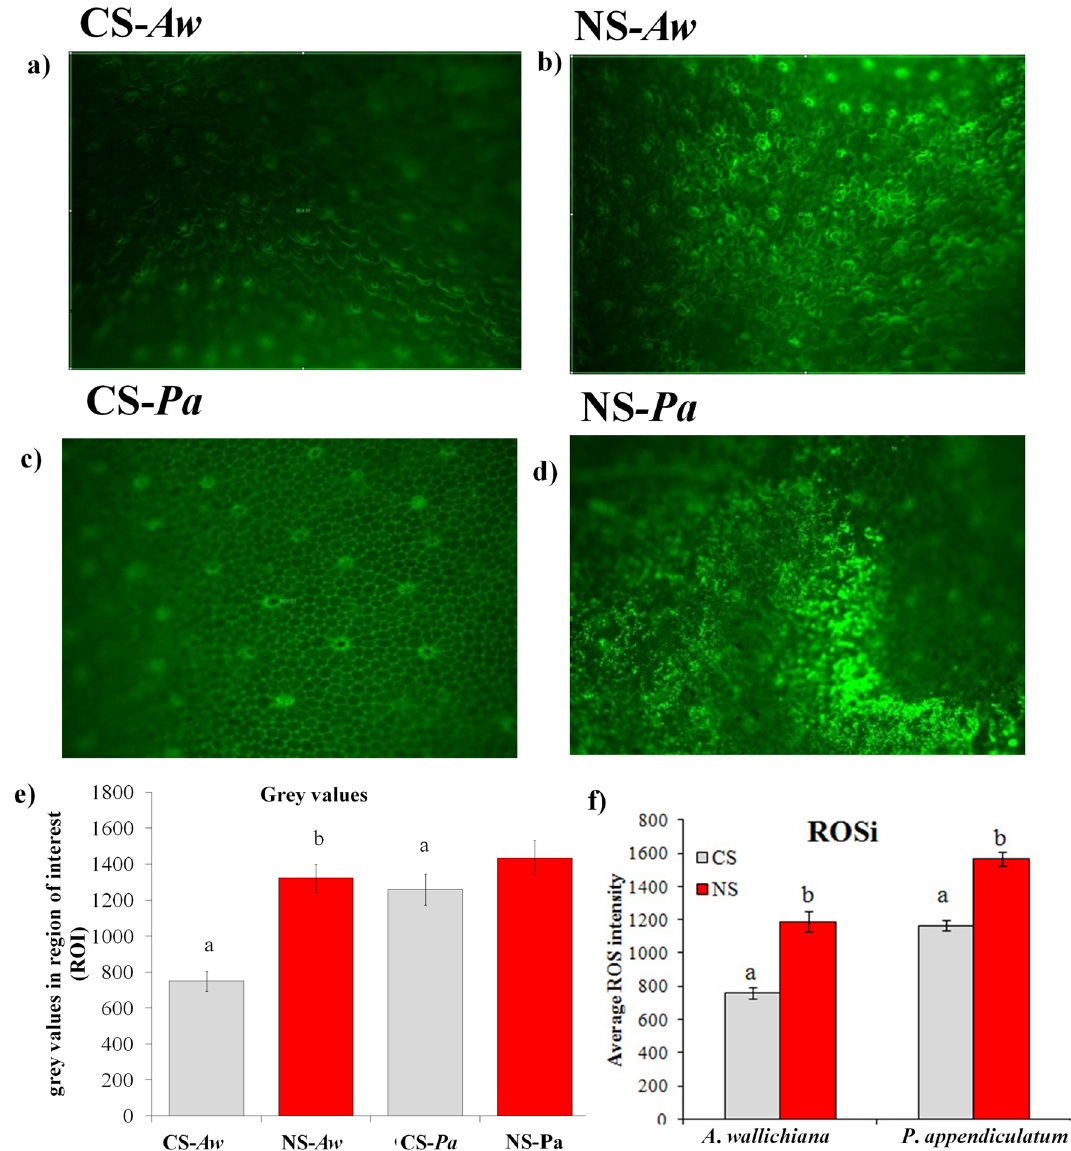
Figure 4. Reactive oxygen species detection in young gametophytic thalli of Asterella wallichiana and Plagiochasma appendiculatum . 2 ′ ,7 ′ -dichlorodihydrofluorescein diacetate (H2DCFDA) based fluorescence microscopy revealed more production of reactive oxygen species (ROS) in the whole thalli of A . wallichiana and P . appendiculatum in nickel excess (NS, n = 5 ) (b, d) compared to control sites ( a, c , respectively) (CS, n = 5 ); (e) , ROS producing regions were imaged and the grey values were calculated by drawing the region of interest (ROI) bearing similar area for the thalli of A . wallichiana and P . appendiculatum for Ni excess sites (NS, n = 5) and control sites (CS, n = 5); (f) reactive oxygen species (ROS)-intensity (ROSi) quantified as a function of grey values in young gametophytic thalli of A. wallichiana and P. appendiculatum grown in control (CS, n = 5) and Ni-excess sites (NS, n = 5). Data presented are means ± standard errors ( n = 5). Different letters (a and b) indicate significant differences from each other in all combinations (Tukey’s test, P ≤